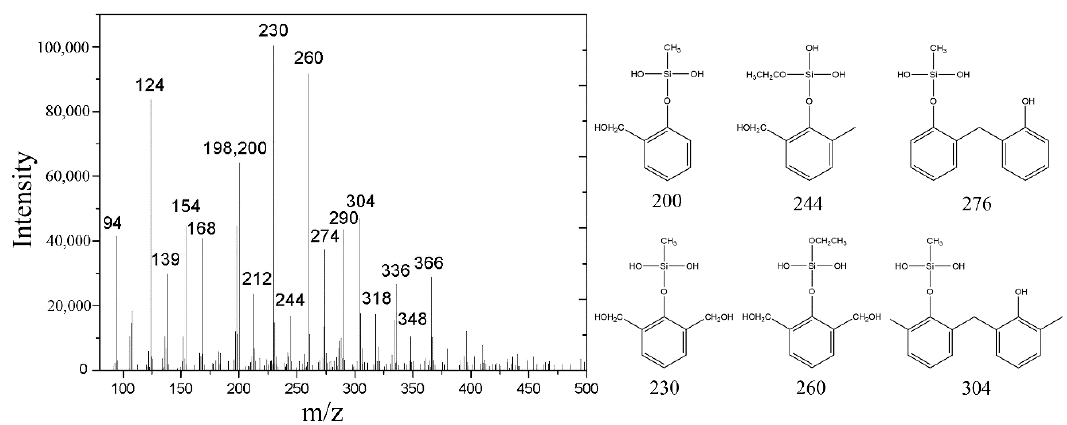
Figure 6. FD-MS spectra of the SPF-4 hybrid resins cured at 80 ◦ C for 2 h and the corresponding Figure 6. FD ‐ MS spectra of the SPF ‐ 4 hybrid resins cured at 80 °C for 2 h and the corresponding chemical structure. chemical structure.